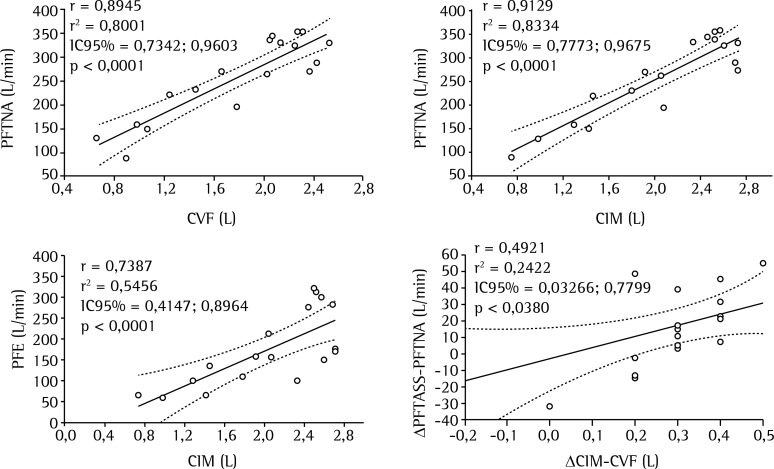
Análise de correlação de dados no pré-treinamento. PFTNA: pico de
fluxo da tosse não assistido; CIM: capacidade de insuflação máxima;
PFTASS: pico de fluxo da tosse assistido; ?PFTASS-PFTNA: diferença entre
PFTASS e PFTNA; e ?CIM-CVF: diferença entre CIM e CVF.